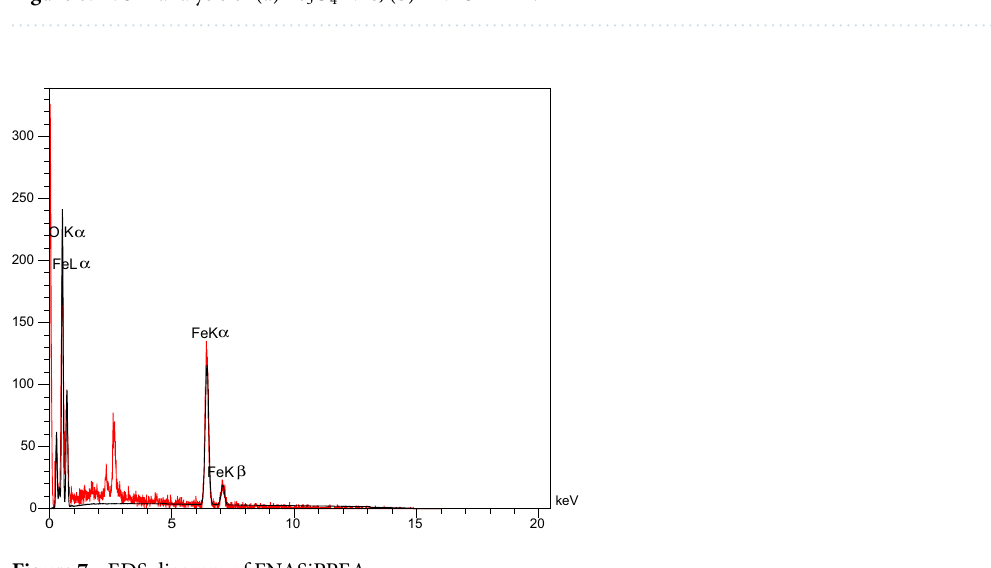
Figure 7. EDS diagram of